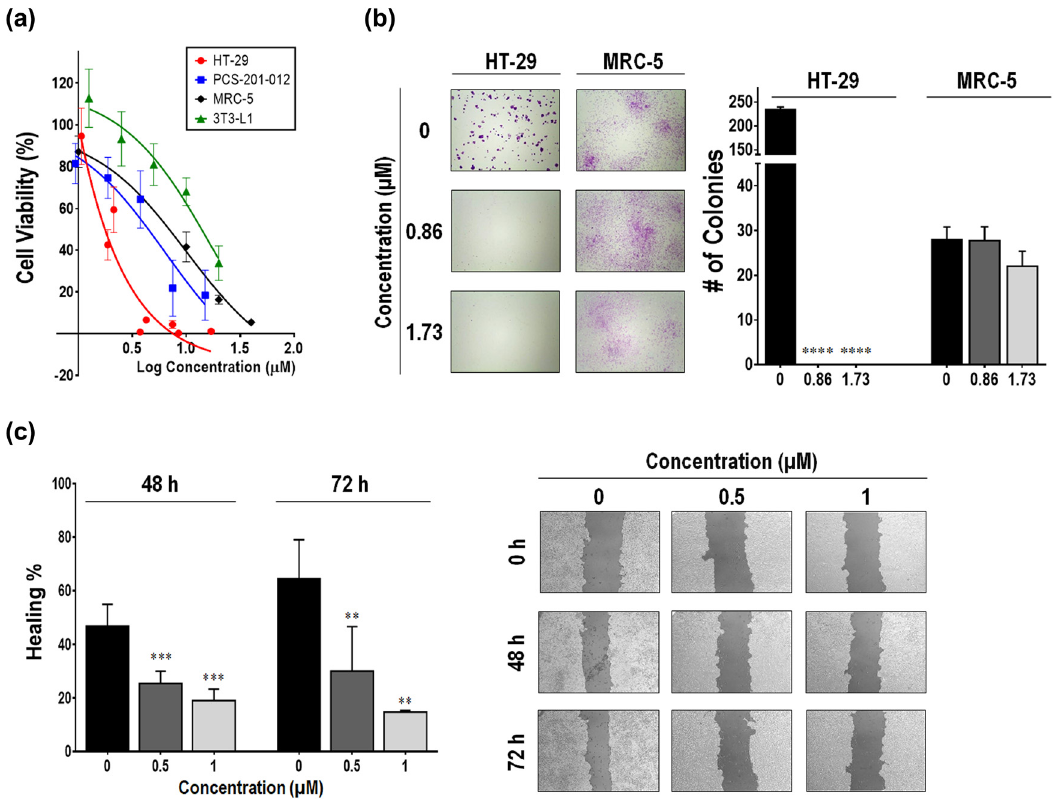
Figure 1: Treatment with 8 - hydroxy - 2 -( 2 - thenoyl ) naphtho [ 2,3 - b ] thiophene - 4,9 - dione ( 1 ) has a CRC - speci fi c inhibitory e ff ect over proliferation and migration. ( a ) Cell viability of CRC cells ( HT - 29 ) versus fi broblasts ( PCS - 201 - 012 and MRC - 5 ) , when treated with compound 1 , was determined with the MTT assay. ( b ) Colony formation assay con fi rmed the selectivity of compound 1 over CRC cells.